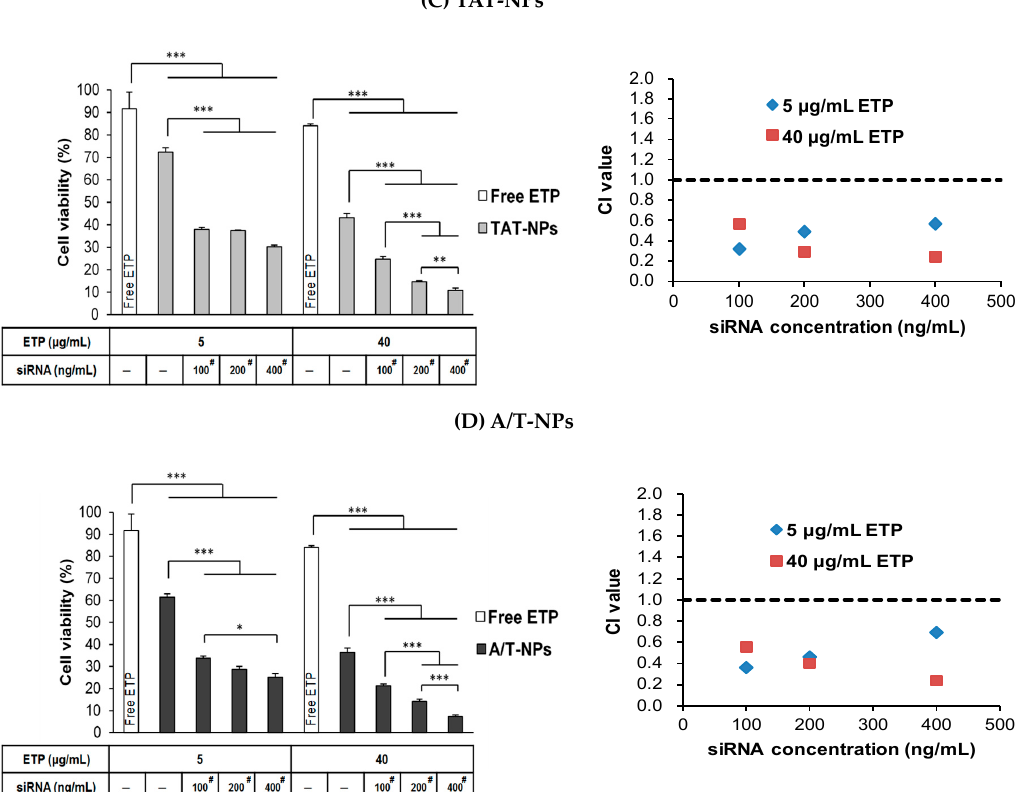
Figure 8. Combination cytotoxicity in CD133( + ) H69 cells and their corresponding CI values after co-treatment of ETP@NPs and siRNA@NPs for 72 h. ( A ) NPs, ( B ) AG-NPs, ( C ) TAT-NPs, and ( D ) A / T-NPs. (* p < 0.05, ** p < 0.01, *** p < 0.001, n = 3). # significant di ff erence compared to NPs-ETP, AG-NPs-ETP, TAT-NPs-ETP, or A / T-NPs-ETP alone.